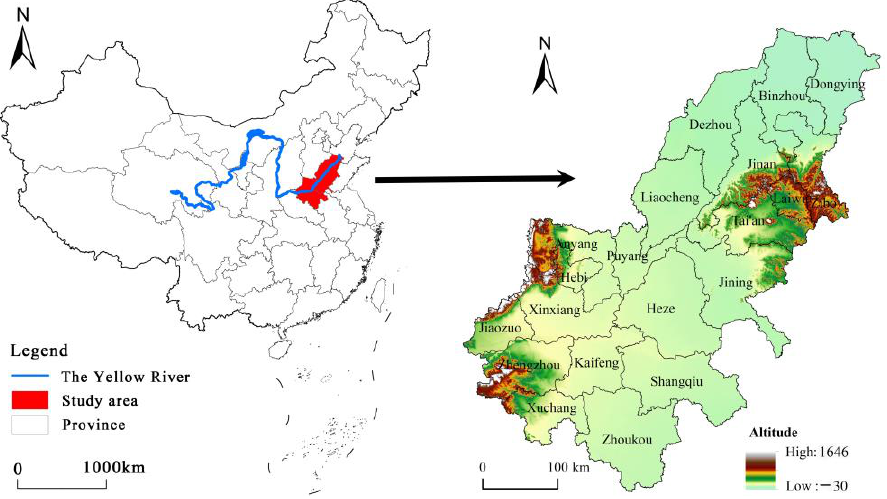
Figure 1. Study area.